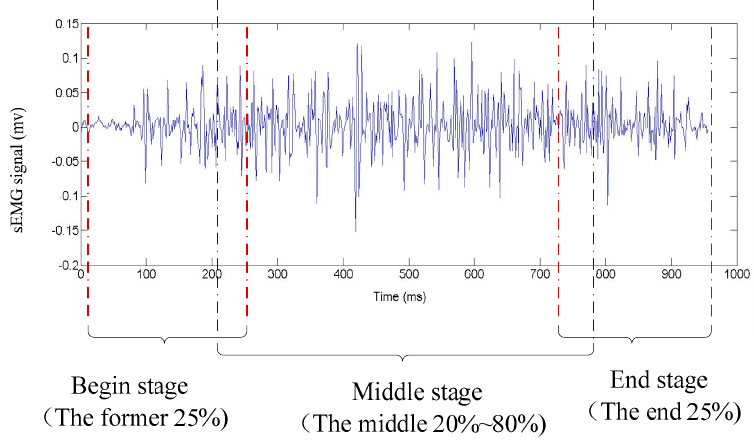
Table 4. Thirteen typical trajectory subclasses.